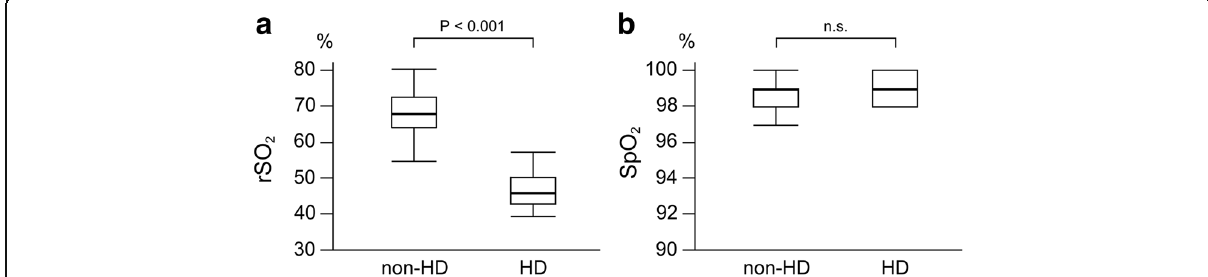
Fig. 1 Box plots of preoperative rSO 2 ( a ) and SpO 2 ( b ) values stratified by HD. Horizontal bold lines represent median values. rSO 2 regional